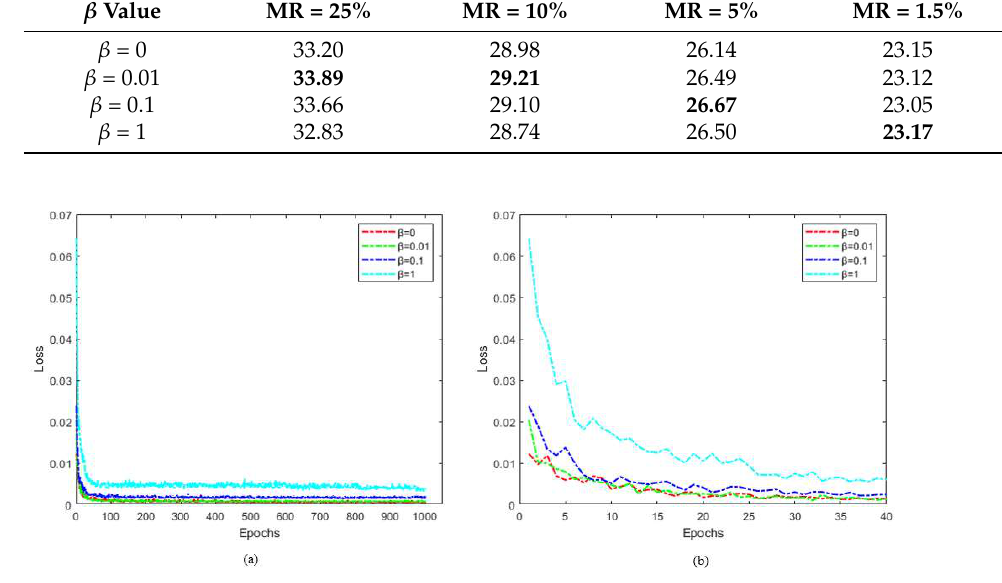
Figure 6. Loss curves of different β values (MR = 25%). ( a ) From the full training process. ( b ) In the 0–40 epoch range.